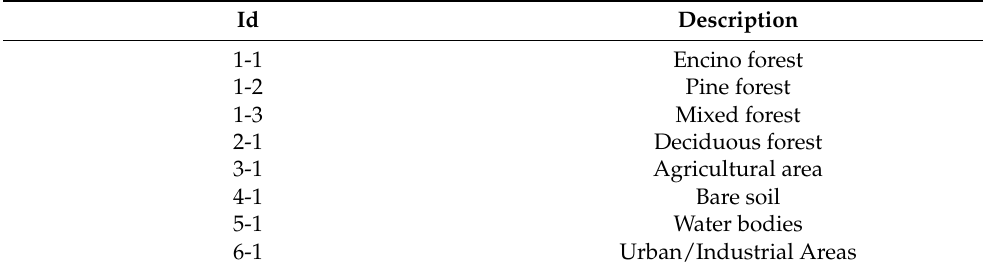
Table 1. Definition of the legend’s categories of LULC for the performance of the classification stage.